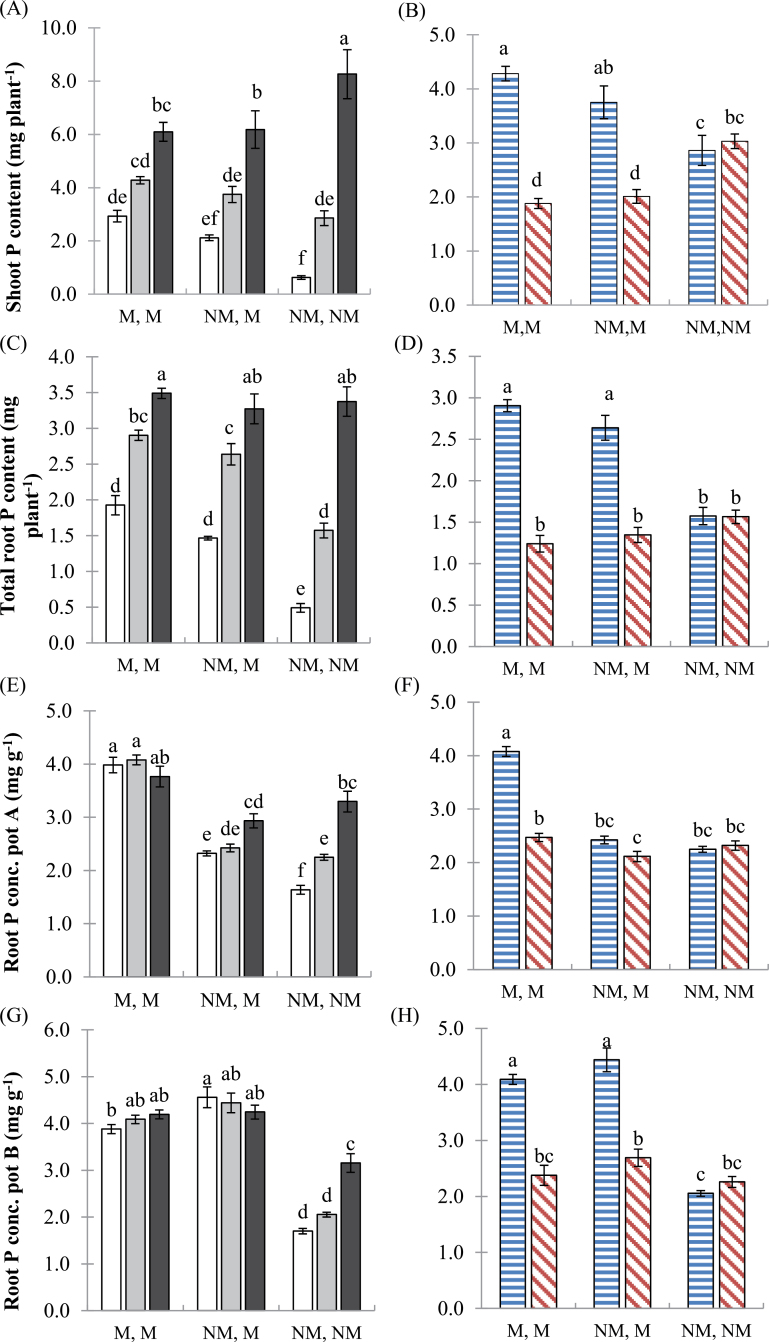
Effects of increasing soil P and AM colonization on plant P content and concentration. Shoot and root P content (mg plant–1), and root P concentration in pot A and pot B (mg g–1) of (A, C, E, G) the wild-type genotype at three soil P additions: 0 (white bars), 20 (grey bars), and 50 (black bars) mg P kg–1, and (B, D, F, H) the wild type (horizontal bars) and mtpt4 mutant (diagonal bars) at P20 only. Values are the mean ±standard error, n=5. Means followed by the same letter were not significantly different at the P<0.05 level. (This figure is available in colour at JXB online.)